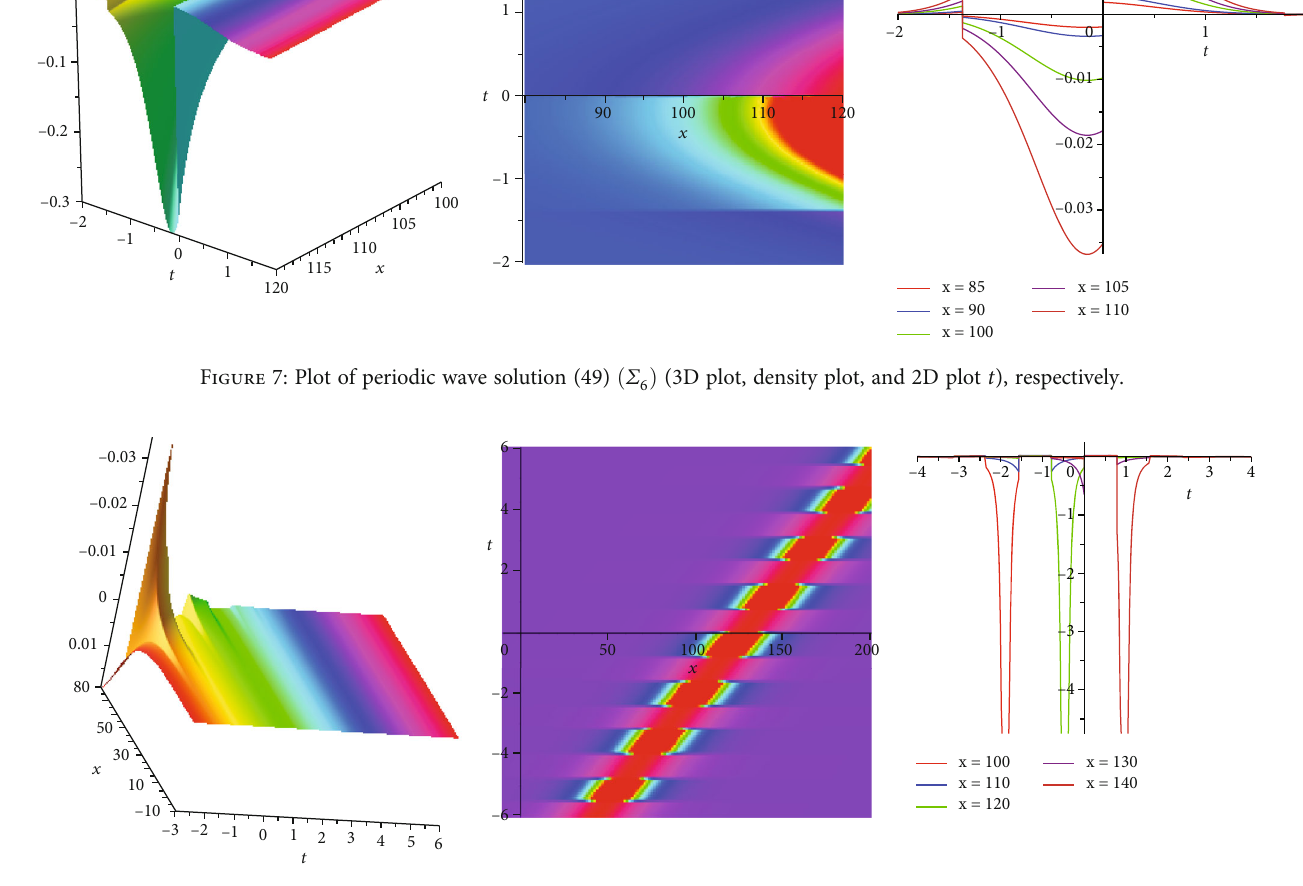
Figure 8: Plot of periodic wave solution (49) ð Σ